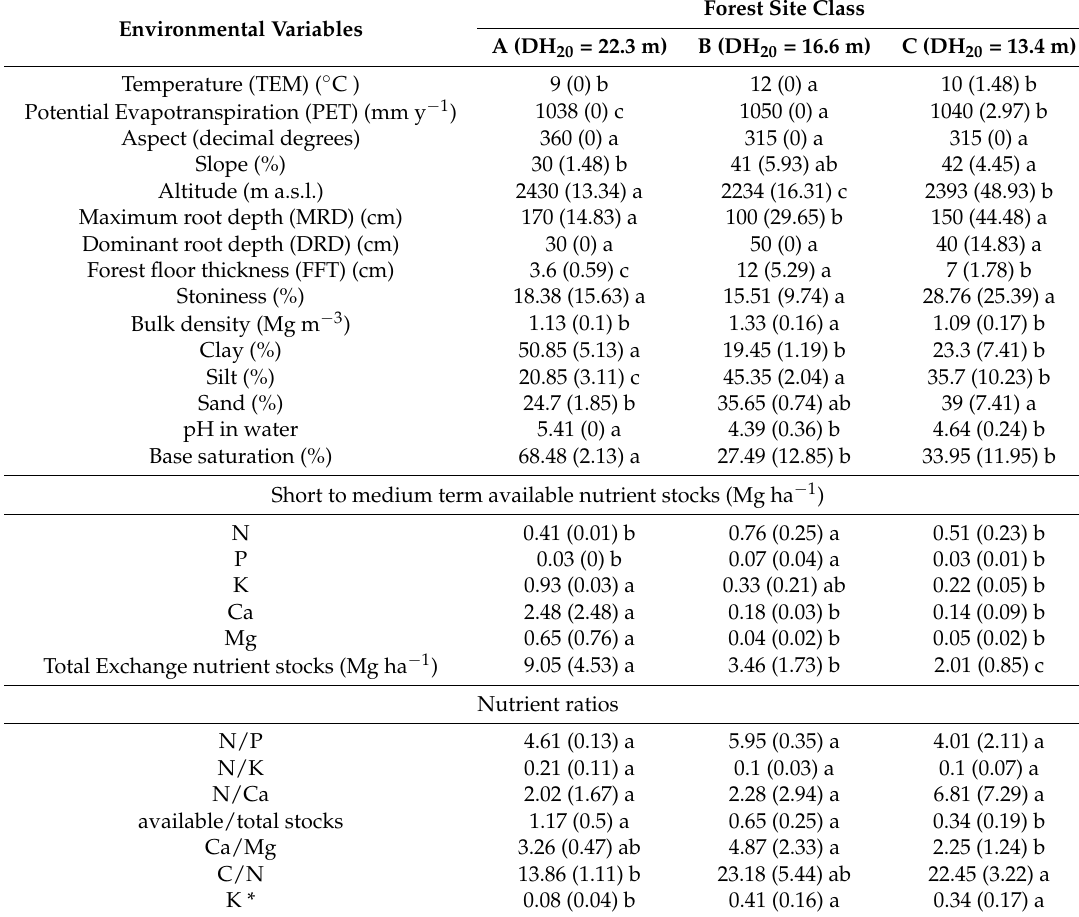
Table 6. Values of the main environmental variables selected after the CART algorithm for the three forest site classes of high, middle, and low productivity (class A, B and C). The dominant height of trees in 20-year-old plantations (DH 20 ) represents the productivity of each class.